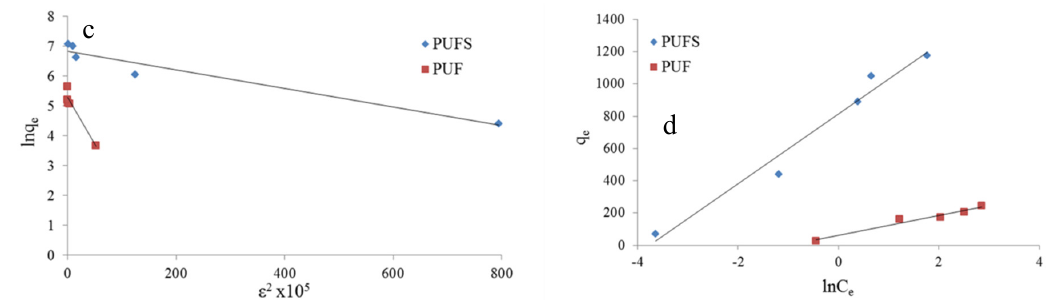
Figure 10. ( a ) Langmuir, ( b ) Freundlich, ( c ) Dubinin–Radushkevich and ( d ) Temkin isotherm models for the sorption of CPF onto white PUF and PUFS. Table 5. List of Calculated Parameters for Adsorption Isotherm of Chlorpyrifos onto White-PUF and PUFS. Isotherms